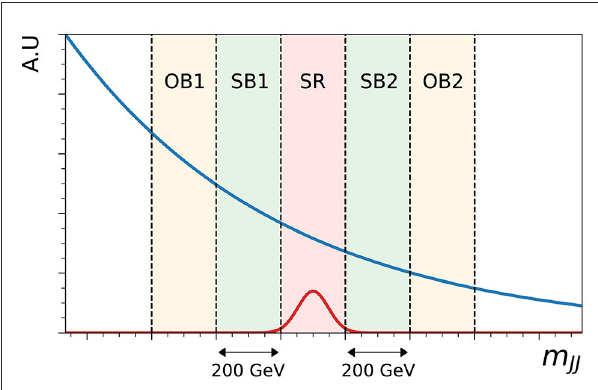
FIGURE2 Schematic showing the relative locations of the two side-bands (SB1 and SB2), the signal region (SR) and the two outer-bands (OB1 and OB2) on the resonant observable m JJ . In this example, the non-resonant background is shown as a falling blue line, and the signal region is centered at 3.5 TeV, corresponding to the mass of the injected signal, shown not to scale in red.